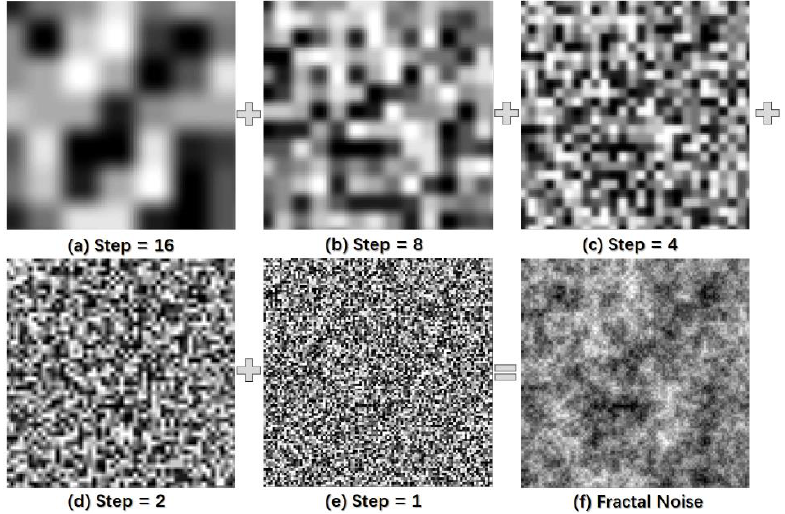
Figure 13. Illustration of fractal noise synthesis.